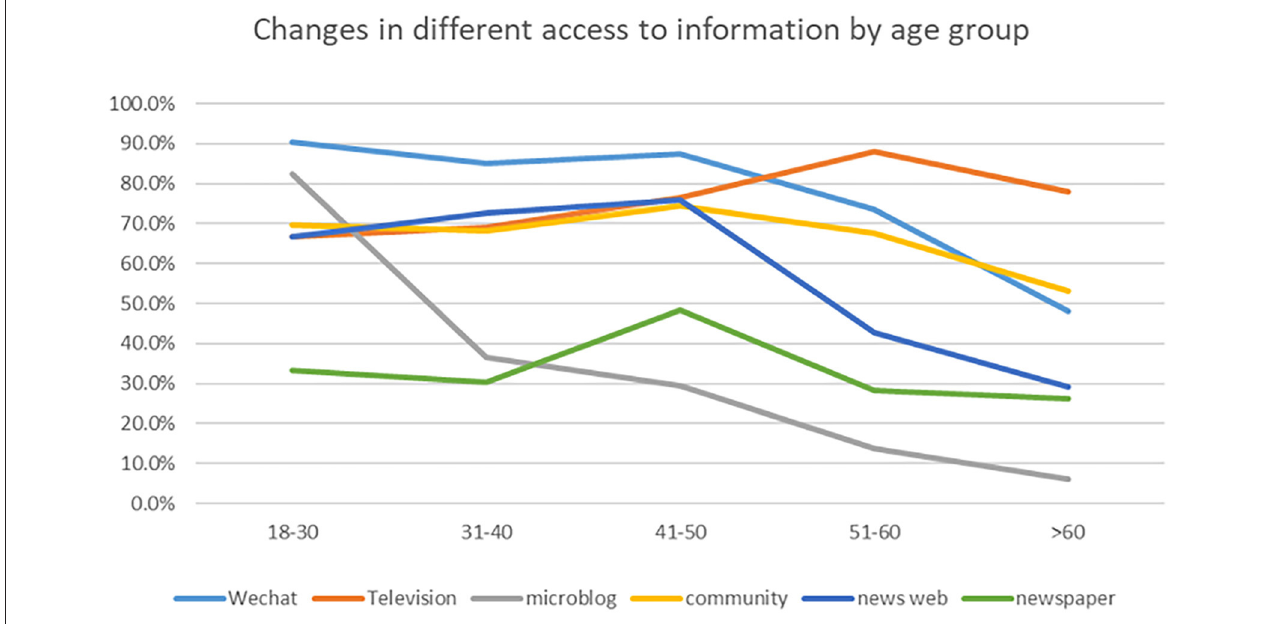
FIGURE 1 | Changes in different access to information by age group.